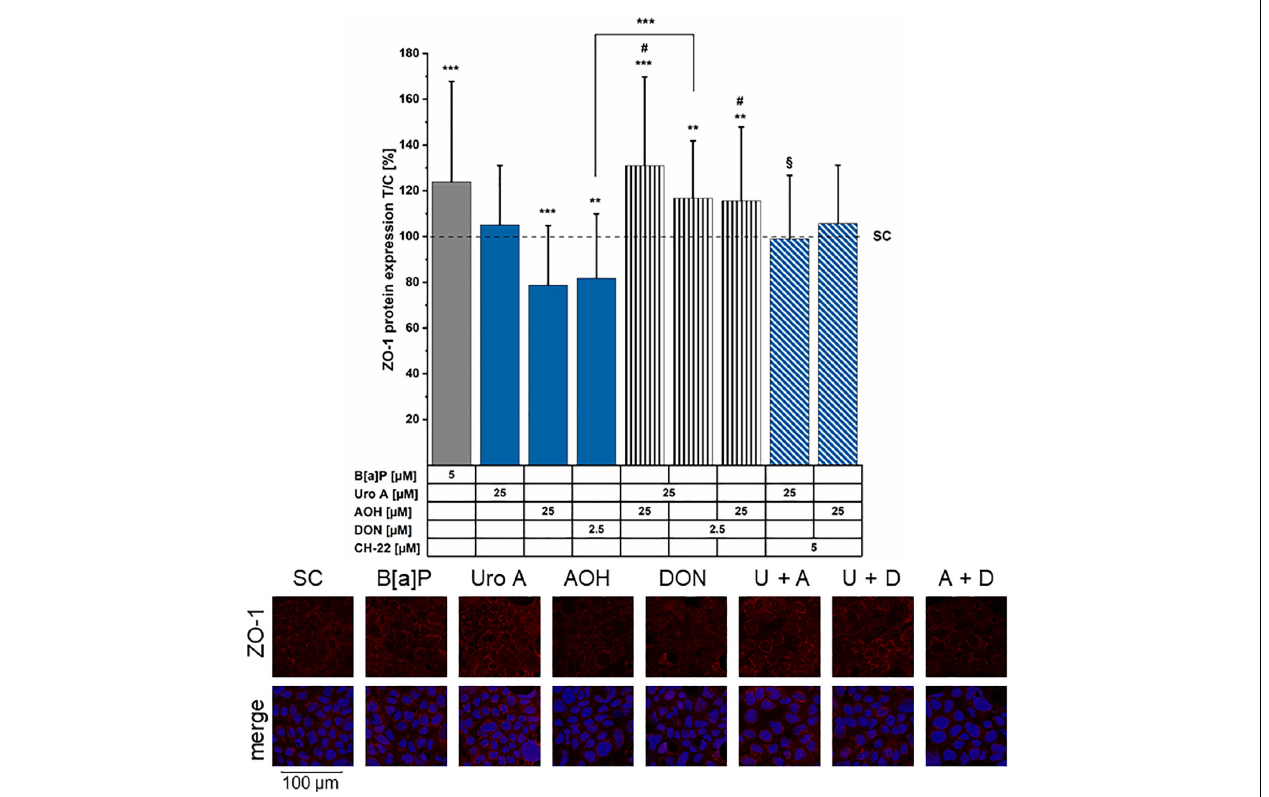
FIGURE 6 | Immunofluorescence staining of ZO-1 protein. ZO-1 was stained after 48 h of incubation period (minimum 4 biological replicates). Fluorescence intensities were normalized to the solvent control (SC) and are presented as test over control (T/C) in percent. Significant differences compared to the solvent control (SC) were calculated by applying two-samples Students’ t -test and are shown as * p < 0.05, ** p < 0.01, and *** p < 0.001. Significant differences of binary combinations compared to both single compounds are marked with # p < 0.01. § p < 0.01 marks differences of combi incubations with CH-22 compared to the expression level of the respective second compounds. In the example images, the abbreviations U for Uro A, A for AOH, and D for DON are used for the combinations. ZO-1 (red) shows ZO-1 immunofluorescence signal only, merge shows the combination of ZO-1 + nucleus